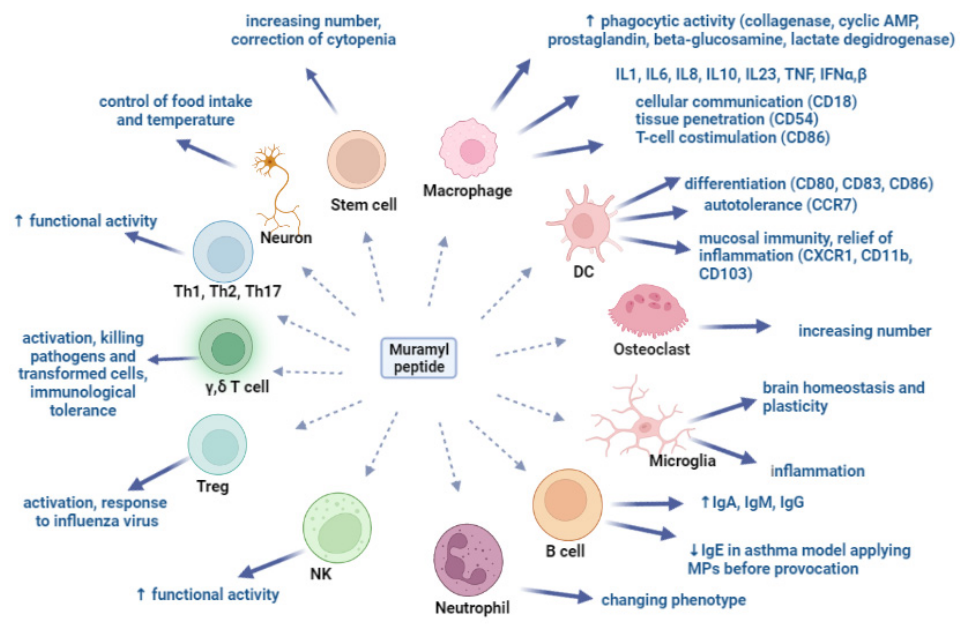
Figure 2. Muramyl peptides activation of various cell populations.